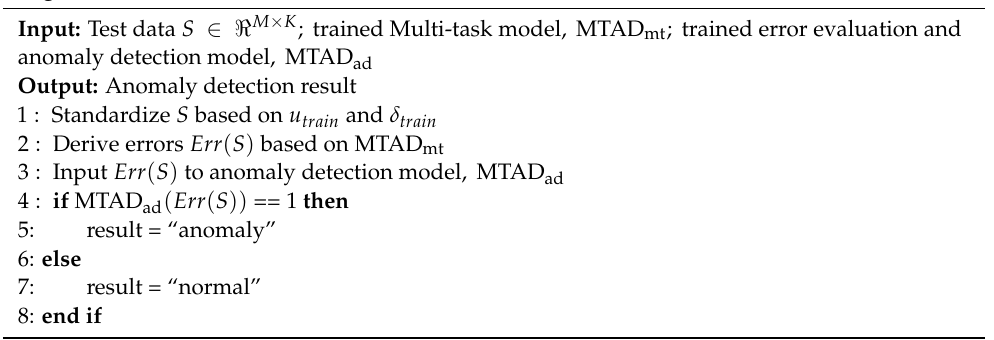
Algorithm 2: MTAD Inference Procedure.